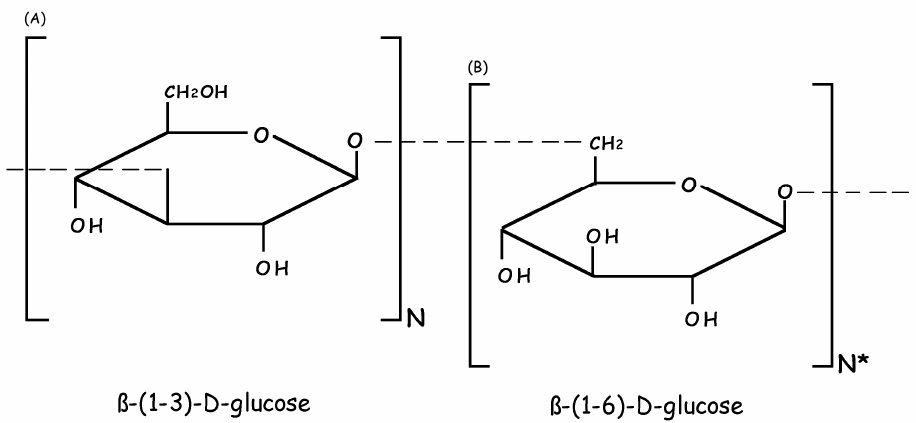
Figure 1. Schematic representation of the basic molecular structures of LAM: ( A ) β -(1-3)- D -glucose linked; and ( B ) β -(1-6)- D -glucose branch. N: number of specific repetitions of β -(1-3)- D -glucose linked; N *: number of specific repetitions of β -(1-6)- D -glucose branch, both according to the species Laminaria spp.